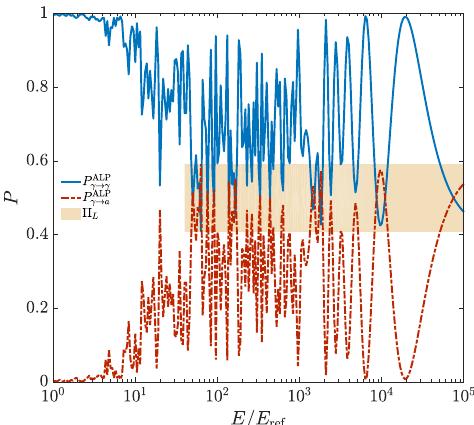
Figure 29. Measure of the initial photon degree of linear polarization Π L ,0 . We show P ALP γ → γ and P ALP γ → a with respect to the energy E ( E ref represents a generic reference energy). The yellow area represents the overlap between P ALP γ → γ and P ALP γ → a and thus the measure of Π L ,0 . In the model photons have been emitted with Π L ,0 = 0.2. The inferred value is very